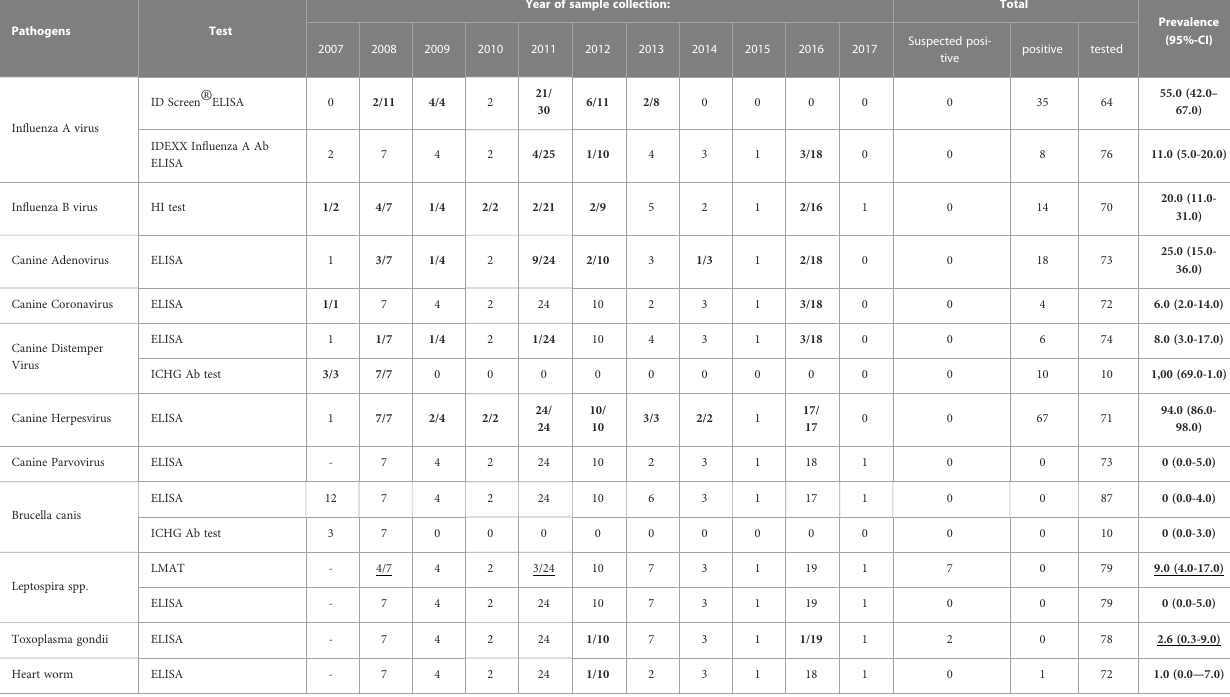
Bold text highlights positive results. Underlined text indicate suspected positives. Prevalence given as x/n, where x is number of samples testing positive, and n is total number of samples tested for each virus in each year. Single numbers indicate number tested with zero positives. ICHG Ab test, Immune-chromatographic rapid antibody test; LMAT, Leptospira microscopic agglutination test.